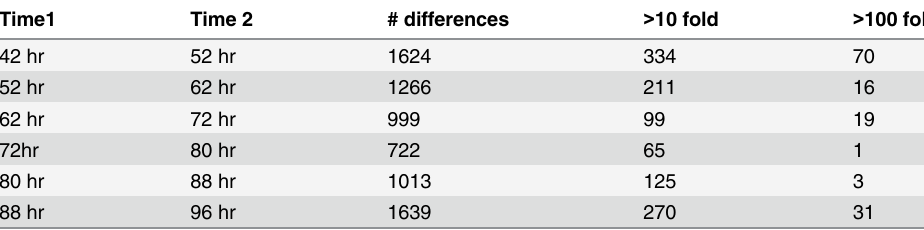
Table 1. Number of genes whose expression level changed between time